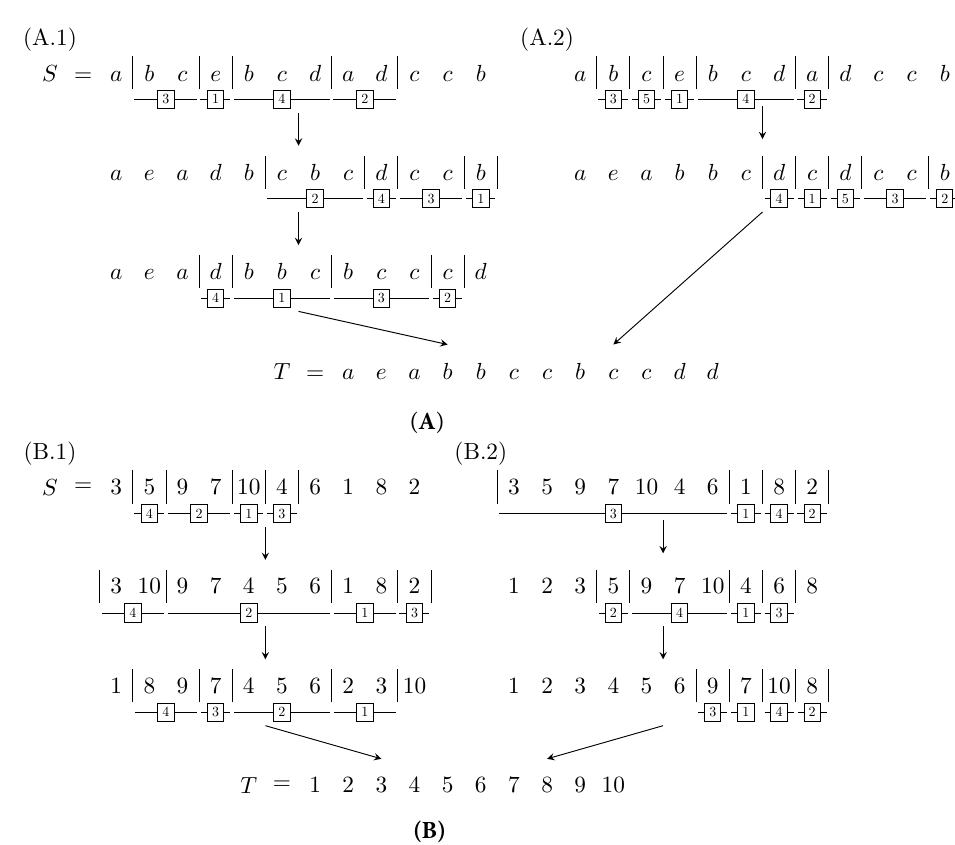
Figure 1. Examples of k -cut rearrangement scenarii. Cuts are represented by vertical lines and the order of the rearranged blocks is indicated by the framed numbers. ( A ) Example on strings S = a b c e b c d a d c c b and T = a e a b b c c b c c d d . ( A.1 ) shows a 5-cut rearrangement scenario with (cid:96) = 3. ( A.2 ) shows a 6-cut rearrangement scenario with (cid:96) = 2. ( B ) Example on permutations S = 35971046182 and T = 12345678910 with b ( S , T ) = 11. ( B.1 , B.2 ) show two alternative 5-cut rearrangement scenarii with (cid:96) =